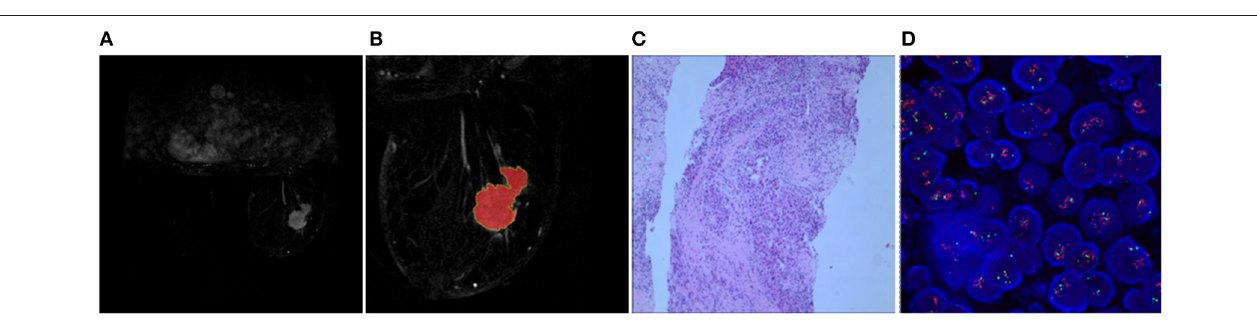
FIGURE 2 | Results obtained from a randomly-selected HER2 2 + positive case. (A) Subtraction image of pre- and post-contrast scans (regular mass and BI-RADS 5). (B) Enlarged image showing the ROI (red region) delineated manually by an experienced radiologist. (C) Pathology results showing IDCS (HER2 2 + gene confirmed